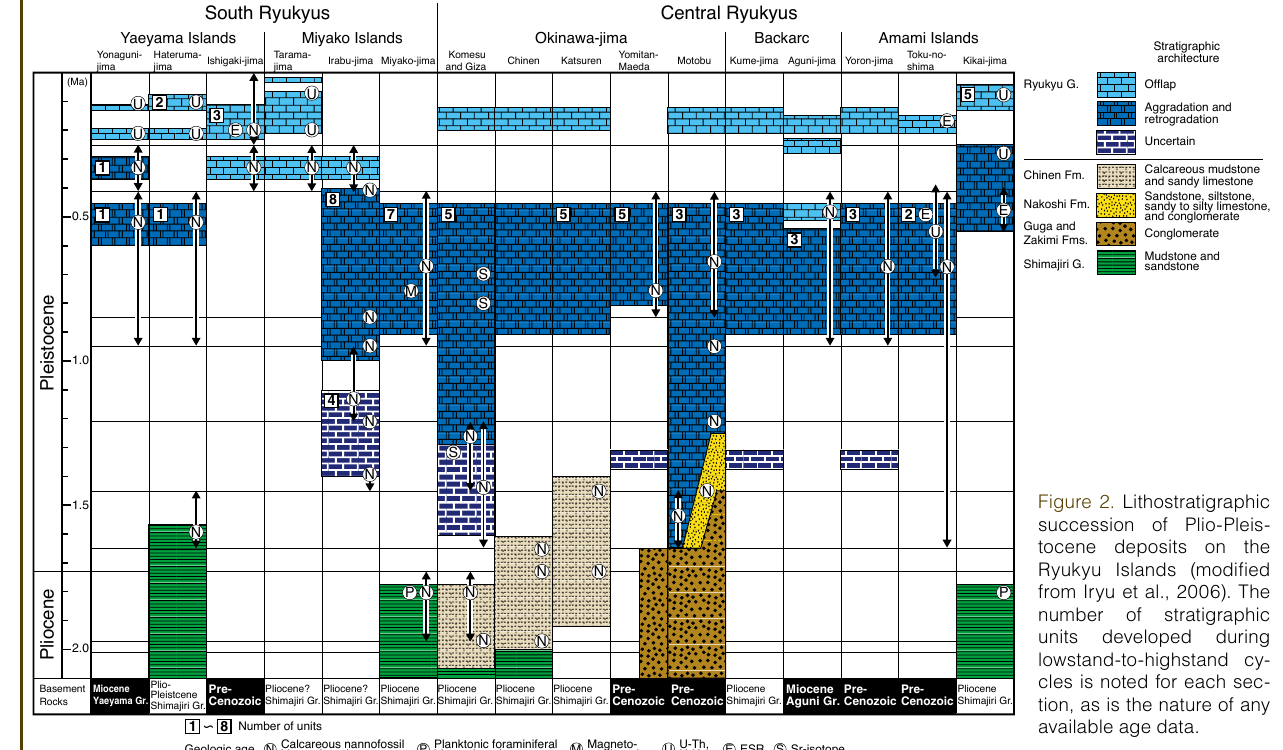
Figure 2. Lithostratigraphic succession of Plio-Pleis- tocene deposits on the Ryukyu Islands (modified from Iryu et al., 2006). The number of stratigraphic units developed during lowstand-to-highstand cy- cles is noted for each sec- tion, as is the nature of any available age